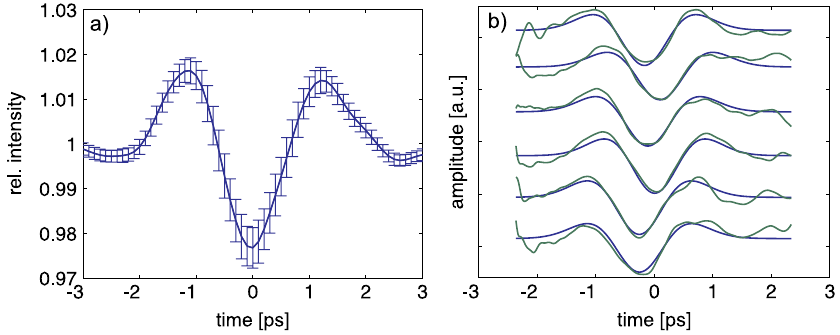
FIG. 10. (a) EOS measurement and (b) several consecutive single-shot EOSD measurements (green curves) together with a fit to two Gaussian-shaped distributions (blue curves). The curves are shifted vertically for better